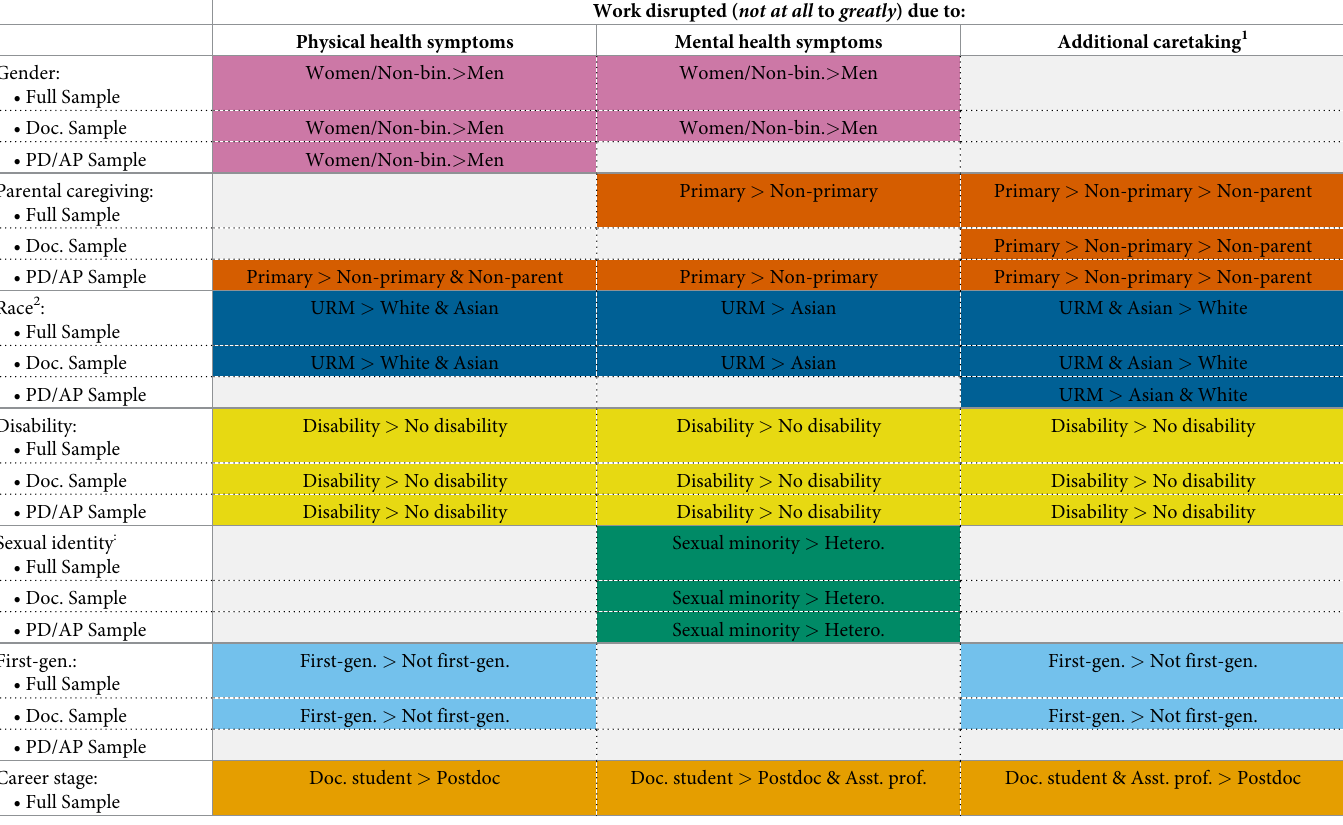
Table 2. Summary of results for all socio-demographic statuses and COVID-19 work disruptions due to life challenges. Work disrupted ( not at all to greatly ) due